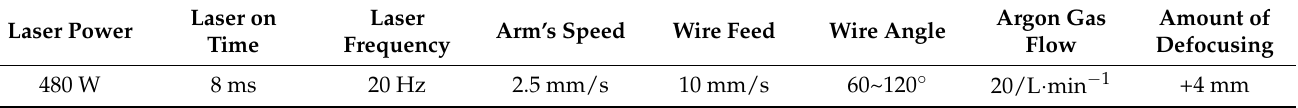
Table 3. Processing parameters.